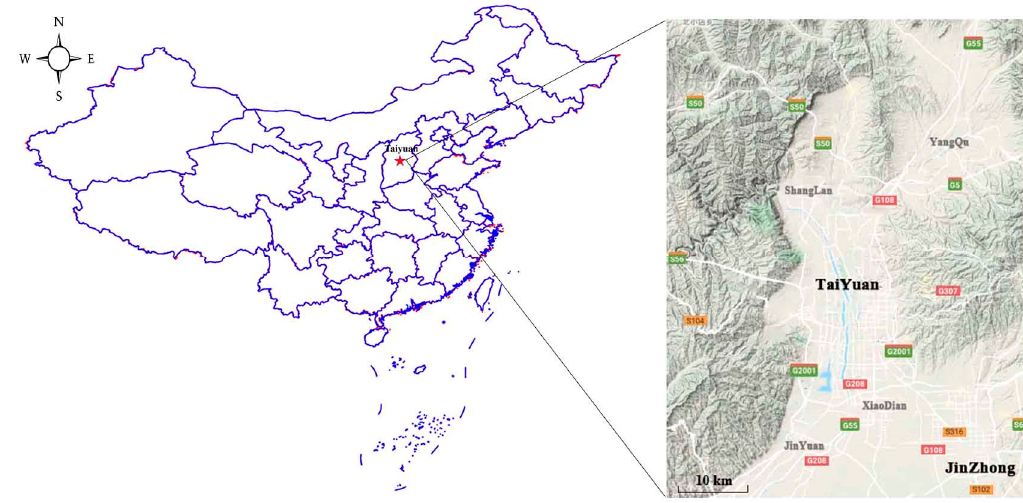
Figure 1. Topographic map of Taiyuan.